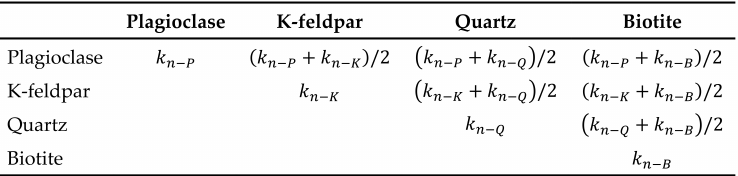
Figure 2. Constitutive behavior of Voronoi grain-model. ( a ) Joint connection mode and fracture criterion, ( b ) Normal stiffness connection between different grains in rock model (modified from [46,47]), ( c ) Calculation table of equivalent stiffness between different grains. Note: k n is equivalent stiffness, k n 1 and k n 2 is stiffness of two adjacent blocks .